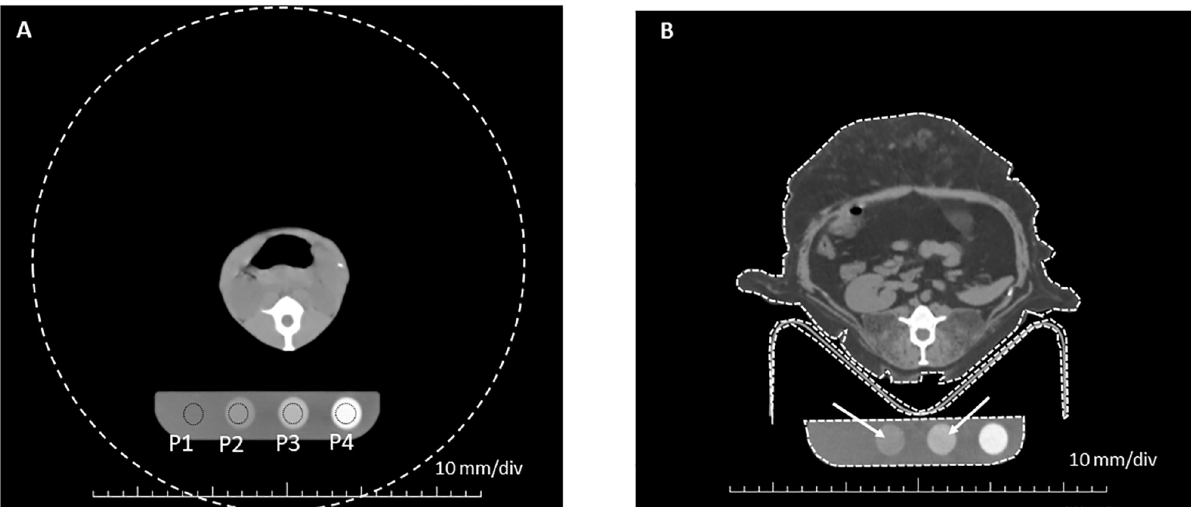
Fig 1. Regions of interest and total signal index. A) Axial image at the level of the right kidney of a small animal in the study. Black circles denote the four phantom ROIs that were traced (P1-P4). The large dashed white circle is the field of view (FOV) of the scan. The area and mean CT# of the FOV ROI were used to calculate the total CT signal index. B). Axial image at the level of the right kidney of a large animal in the study. White dashed lines show an example of the ROIs that were hand traced to measure the total cross sectional area of tissue and material in the slice. This particular slice was not used in the phantom study because of the presence of the trough. The trough shadow artifact in P3 can be seen (white arrows). This slice was selected for the figure because it is at the same anatomical level as the slice for the smaller animal in Fig 1A.